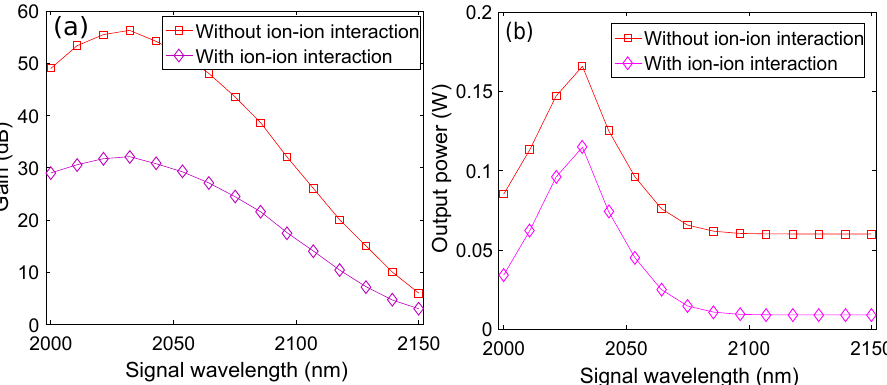
Figure 8. Input signal wavelength versus ( a ) Gain plots without and with ion-ion interaction ( b ) Out- put power plots without and with ion-ion interaction. Table 3. Values of various parameters used in the analysis of ion-ion interaction. Sr.